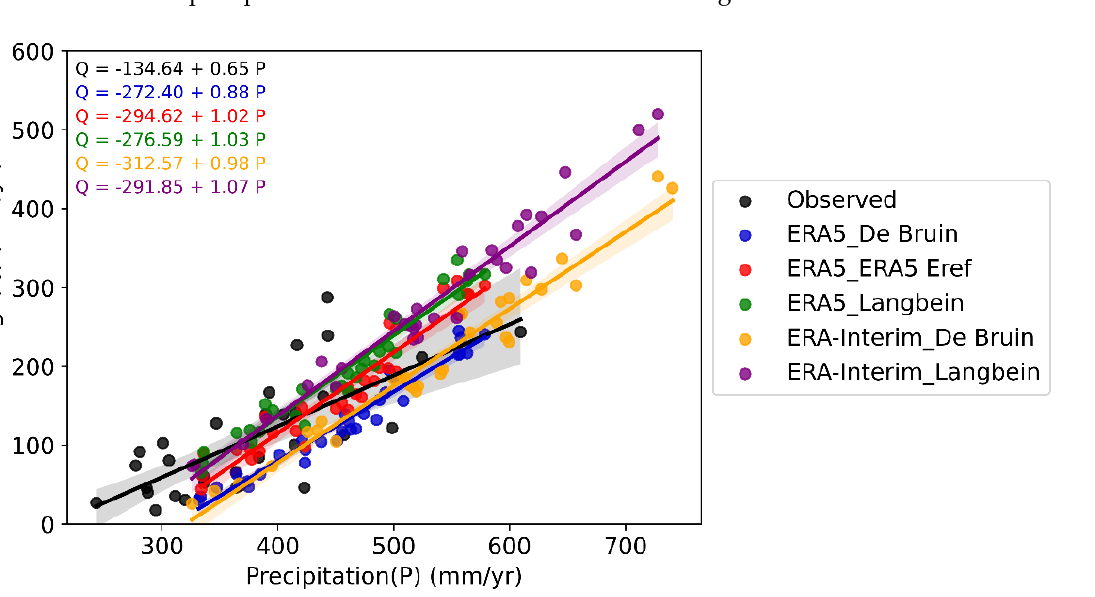
Figure 8. Scatter plot of precipitation versus discharge for the entire period in the Urmia Lake Basin.